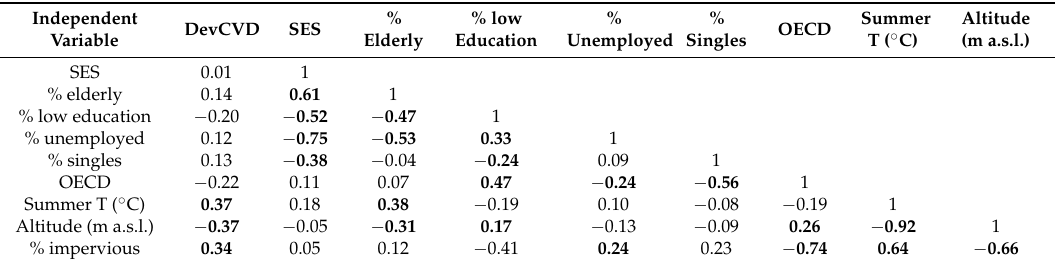
Table 3. Spearman’s correlation matrix comparing the mean relative excess mortality due to CVDs on hot days ( DevCVD ) with independent variables used in the analysis (see Table 1 for description). Significant coefficients with p -value < 0.05 are in bold.